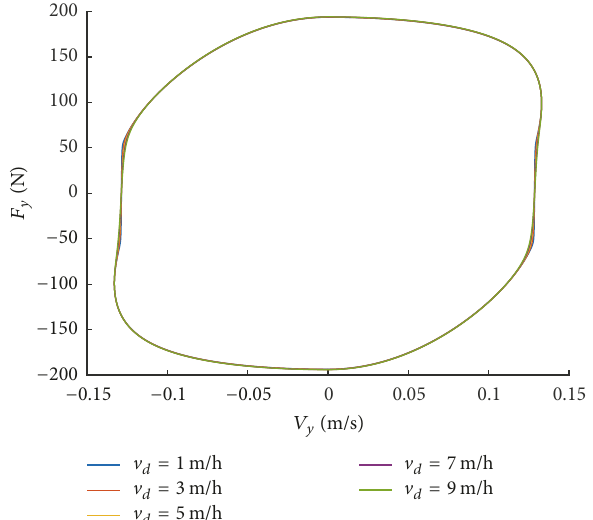
Figure 17: Trajectory of general bristle end point projection. Tiny distinction of tangential force led to larger difference of axial friction in the range of drilling engineering